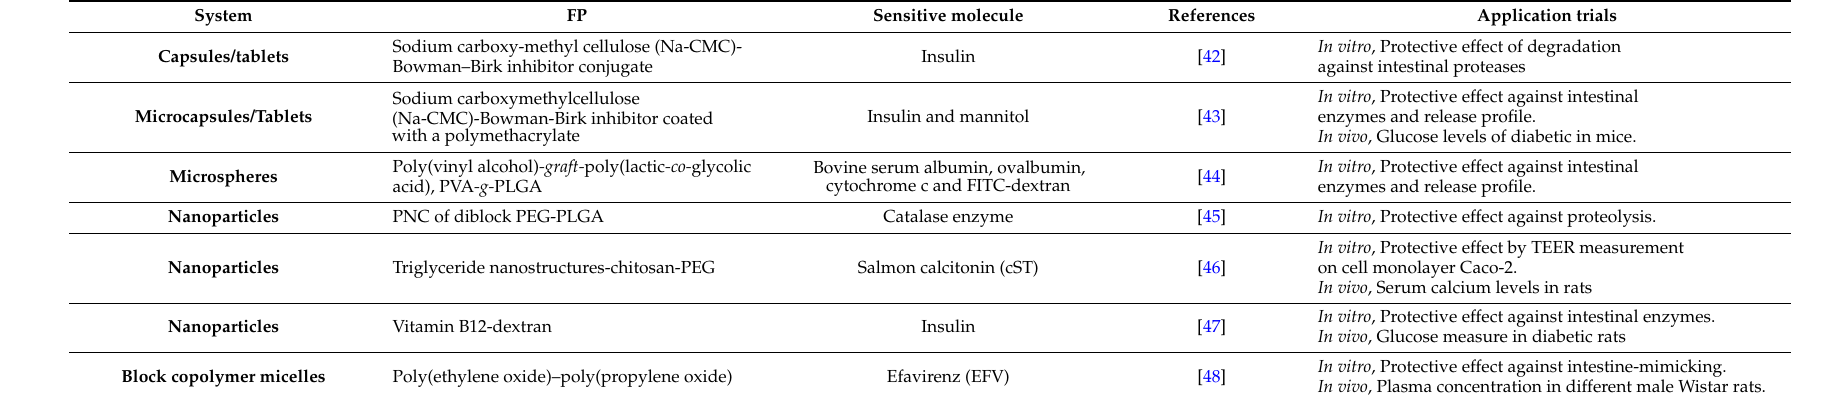
Table 2. FP systems with protective enzymatic degradation as enhancement of sensitive